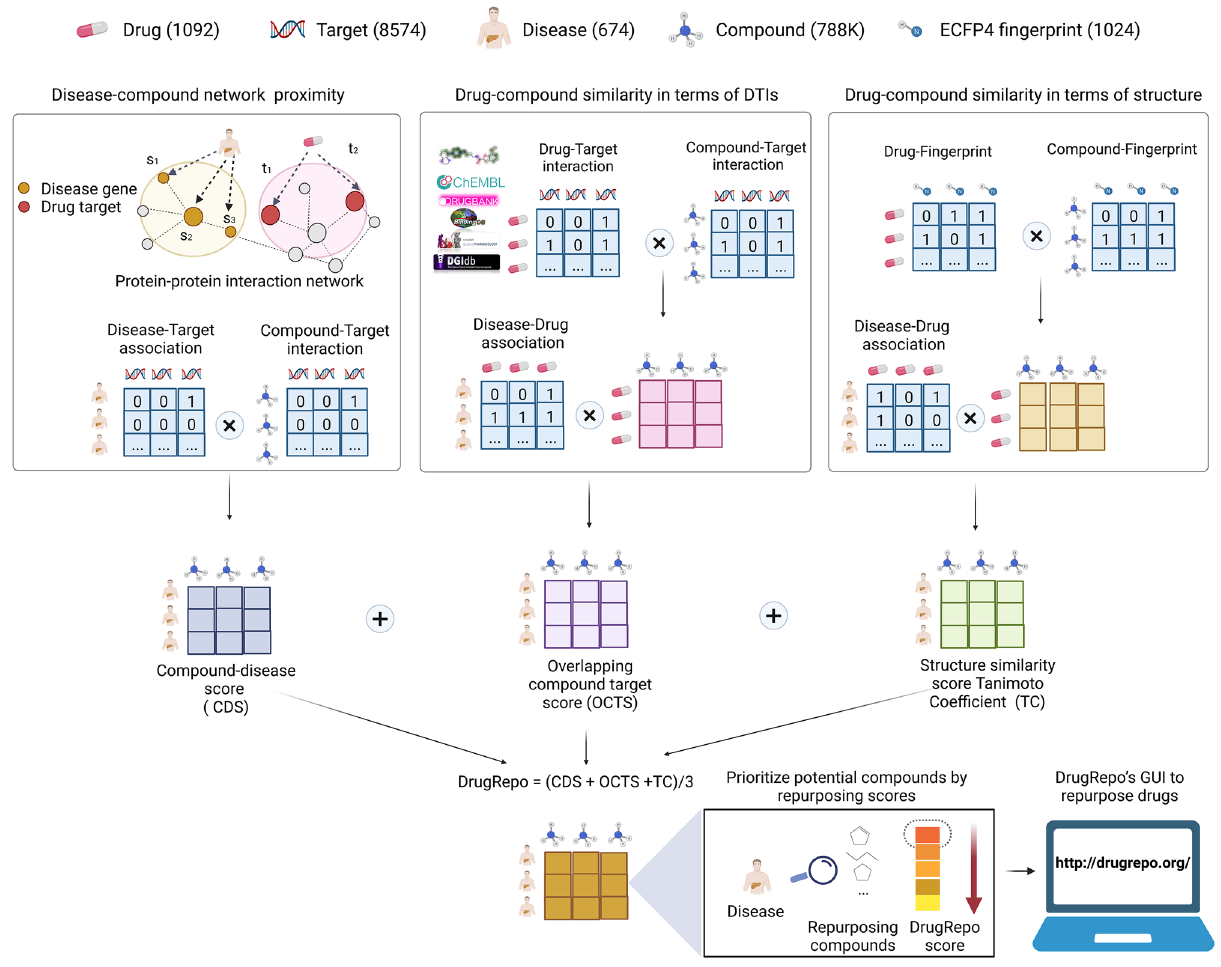
Figure 1. The schematic figure for drug repurposing in DrugRepo. The DrugRepo pipeline starts with the user selecting a particular disease. There are ~ 0.8 M candidate compounds in DrugRepo that can be repurposed or rescued for 669 diseases. At first, the pipeline finds approved drug(s) for the selected disease and searches for structurally similar drugs or compounds. In this step, the Tanimoto coefficient (TC) describes the structural similarity between molecular fingerprints (ECFP4) of approved and candidate compounds. A threshold is used to favor similar molecular structures. The second step is to compute DTI profiles for candidate compounds and approved drugs. The OCTS is the score based on overlapping DTIs between approved and candidate compounds. In case of multiple approved drugs for a disease, we took average of OCTS and TC scores. The third step is to compute the compound-disease score (CDS). The CDS is the average of the minimum distances in the PPI networks between target molecules and molecules associated with the selected disease. The average distance is normalized to 0–1. Finally, the DrugRepo score is calculated as the average of the three component scores. The higher the DrugRepo score between the approved drug and the candidate compound, the higher the possibility of repurposing the compound for a particular disease. Finally, we developed the DrugRepo’s GUI to provide a user-friendly service for repurposing drugs with our pipeline. The OCTS between approved and candidate compounds are computed using Eq. 1. The OCTS ranges from 0 to 1 and represents the proportion of targets shared between an approved drug and the candidate compounds. Candidate compounds sharing more targets with the approved drugs will have higher OCTS